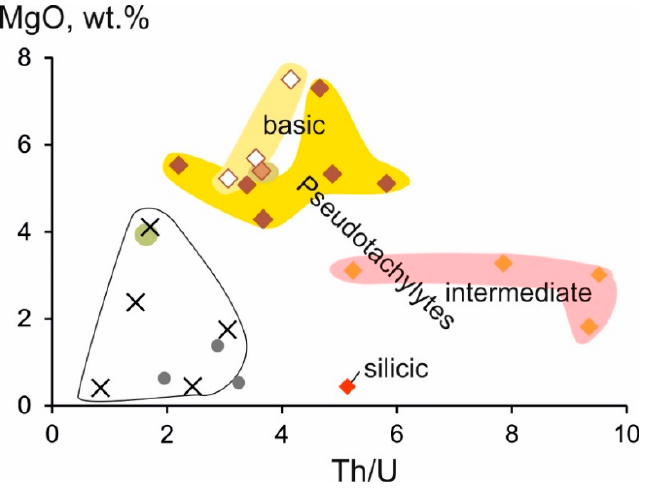
Figure 6. Pseudotachylytes, mylonites, and epidote-chlorite rock from the MSF on a MgO-Th/U diagram. Symbols are as in Figure 4.